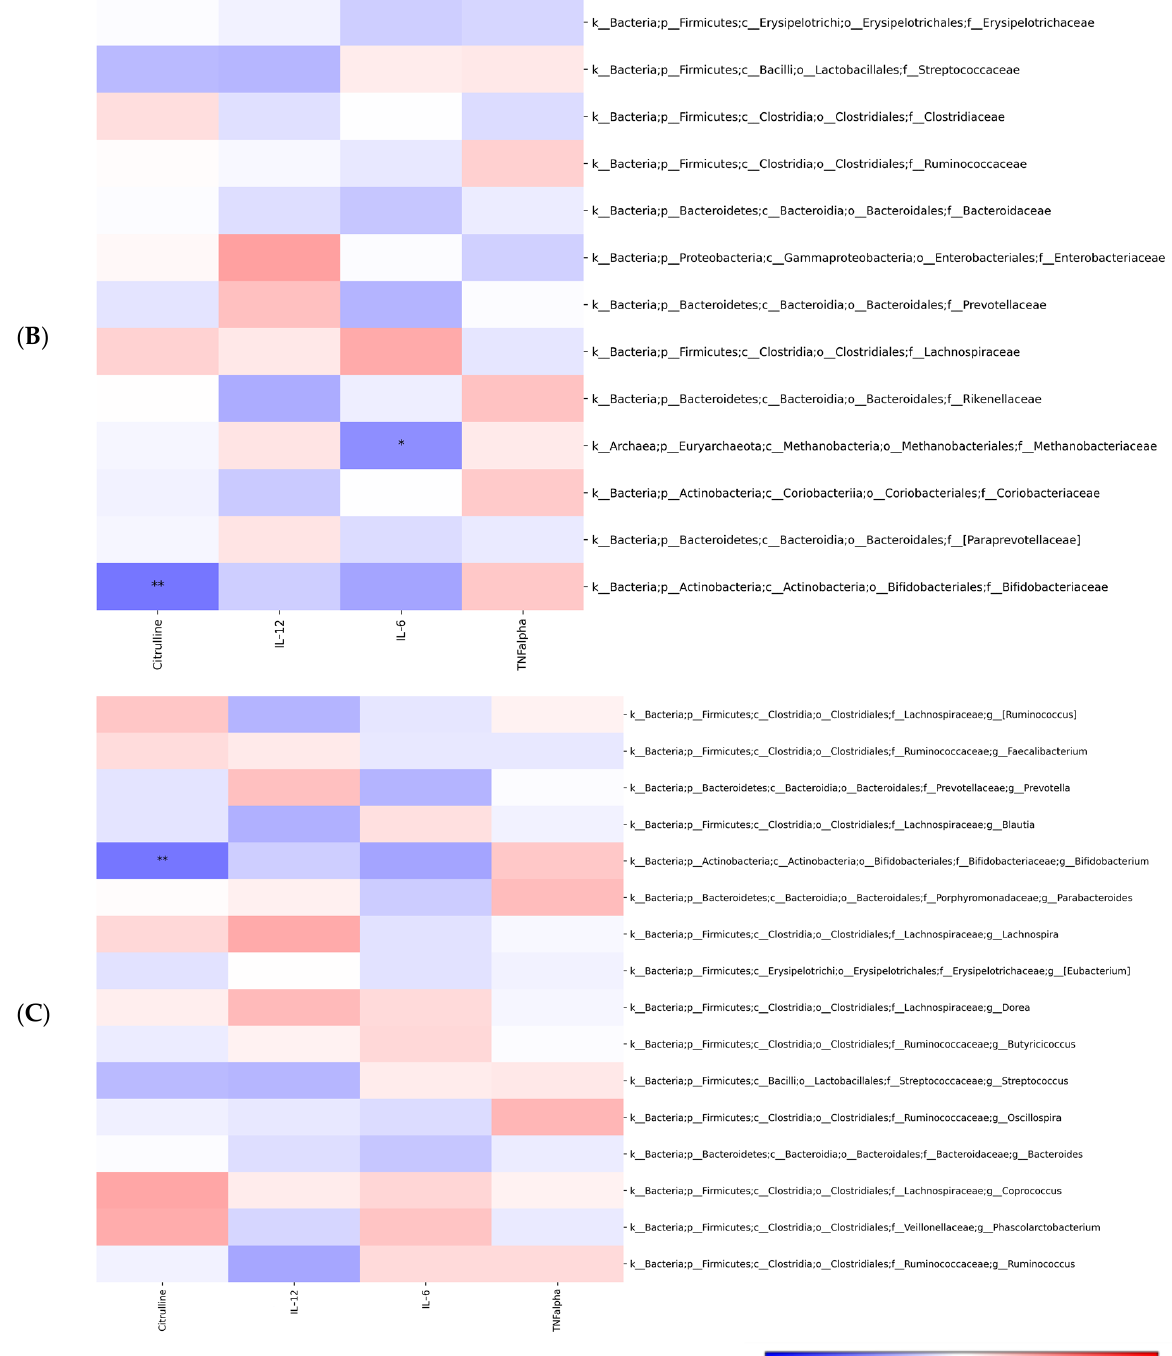
Figure 7. Spearman’s correlation between citrulline, IL-12, IL-6, TNF-a and ASV. Spearman’s correlation is represented at L2-phylum ( A ), L5-family ( B ) and L6-genus ( C ) levels (FDR adjusted p values < 0.05). The statistical significance is represented with * for p -value < 0.05, and ** for p -value < 0.01.